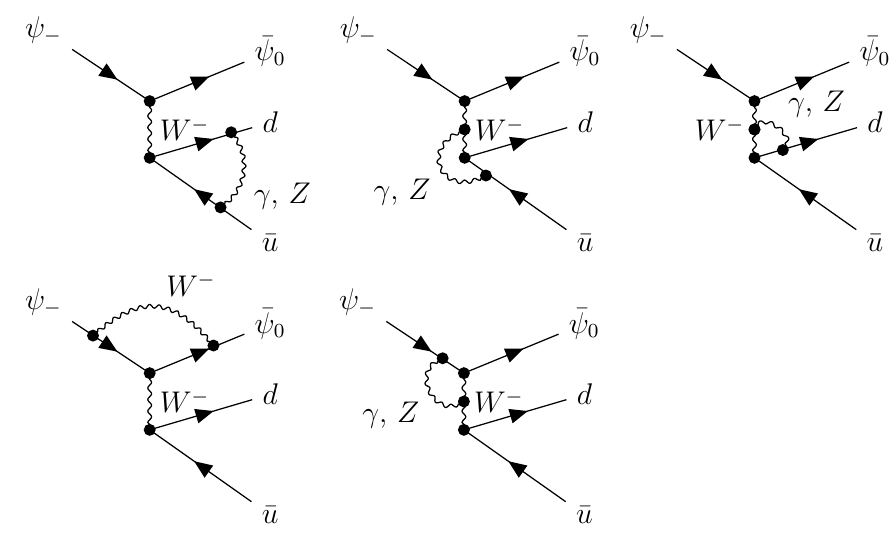
Figure 5 . The contributions of the vertex corrections to the Wino decay into the free quarks in the electroweak